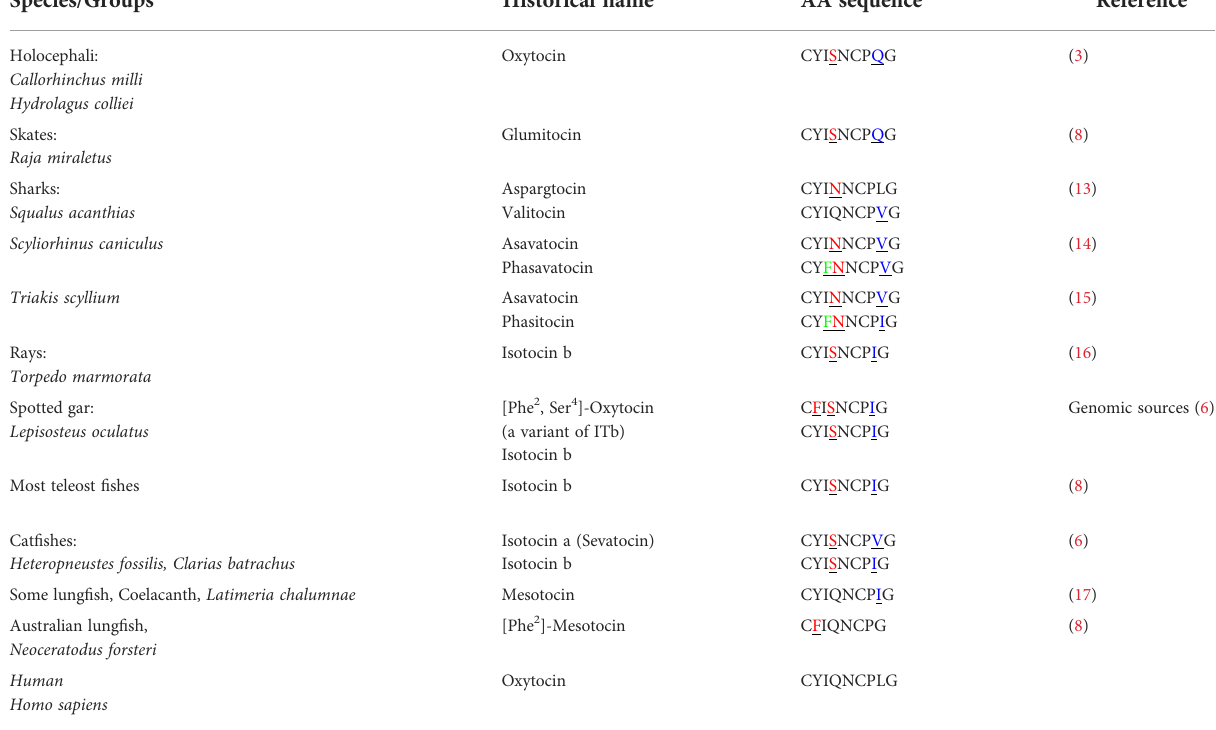
TABLE 1 Oxt nonapeptide family orthologues in different fi sh groups.